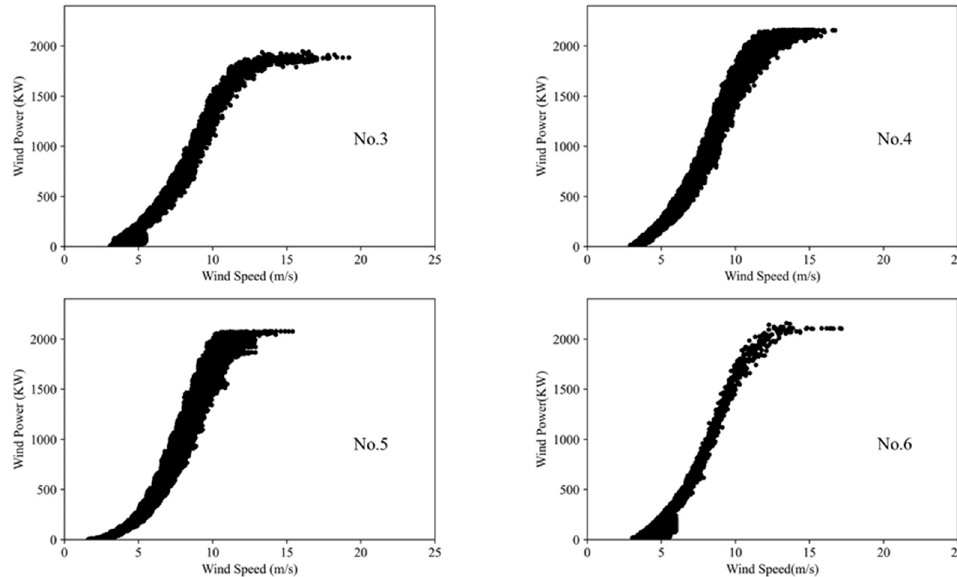
Figure 8. Abnormal data filtering result via proposed method.